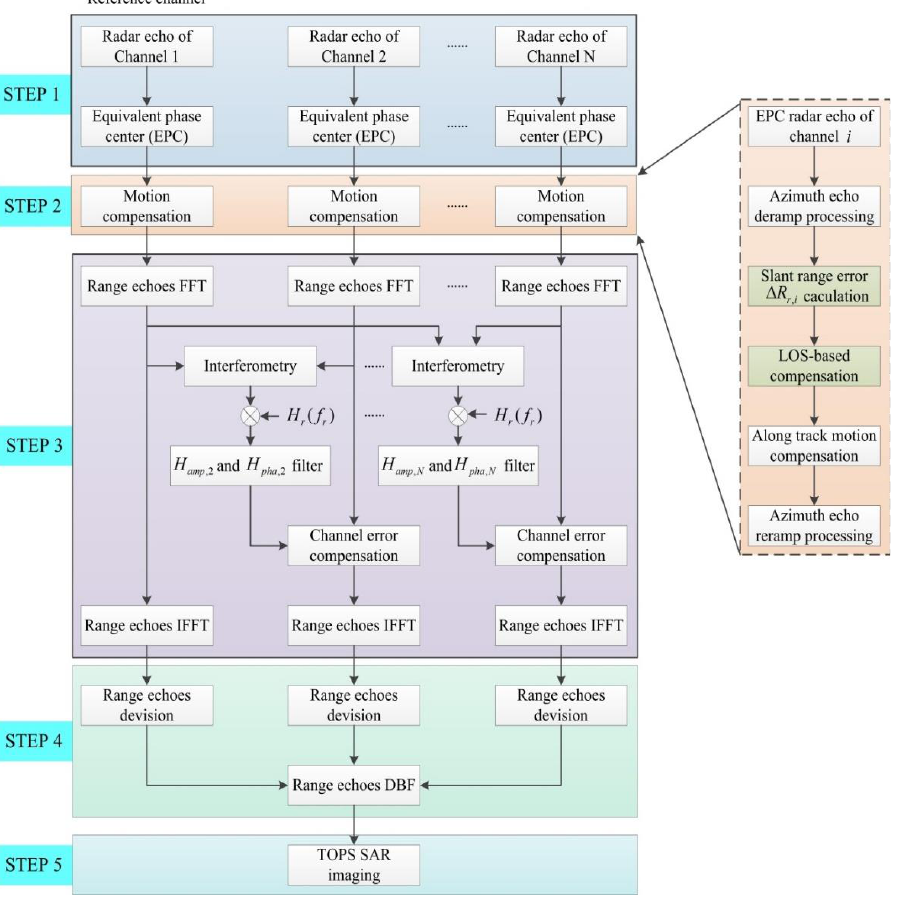
Figure 6. Flowchart of DBF-TOPS SAR imaging with LOS MoCo and channel equalization.